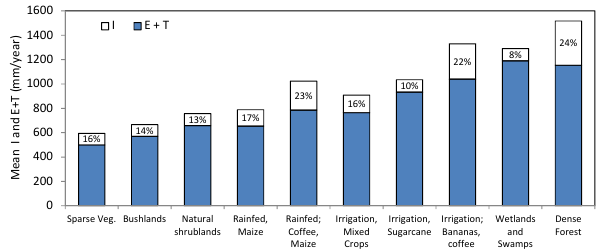
Figure 7. Mean interception, I , and evaporation depletion, E + T for different land use classes in upper Pangani River basin for the period